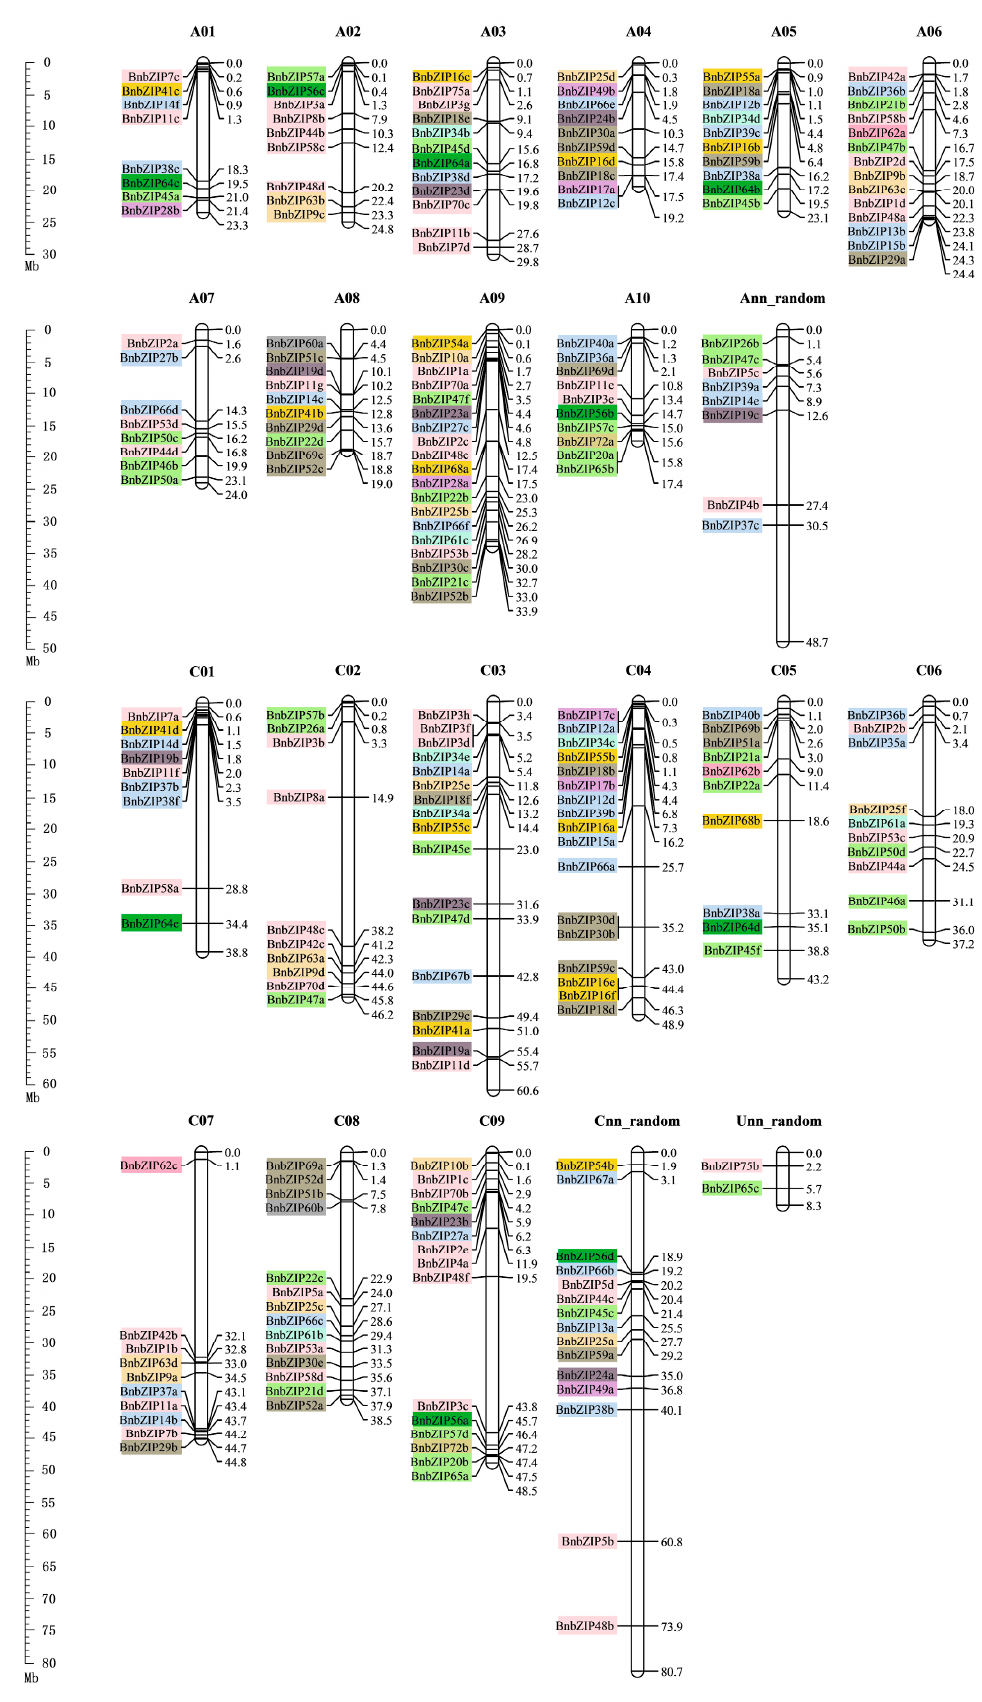
Figure 4. Distribution of BnbZIP gene family members on the B. napus chromosomes. The 222 BnbZIP genes for which exact chromosomal information is available in the database were mapped to the 19 B. napus chromosomes. Genes from the same subtribe are indicated by the same color, which is consistent with the corresponding family in the evolutionary tree. The scales were indicated the genome size of B. napus genome (Mb). A01-A10 and C01-C09 indicate the chromosomes of B. napus . Ann_random: unmapped A Chromosomes of B. napus genome; Cnn_random: unmapped C Chromosomes of B. napus genome; Unn_random: unmapped Chromosomes of B. napus